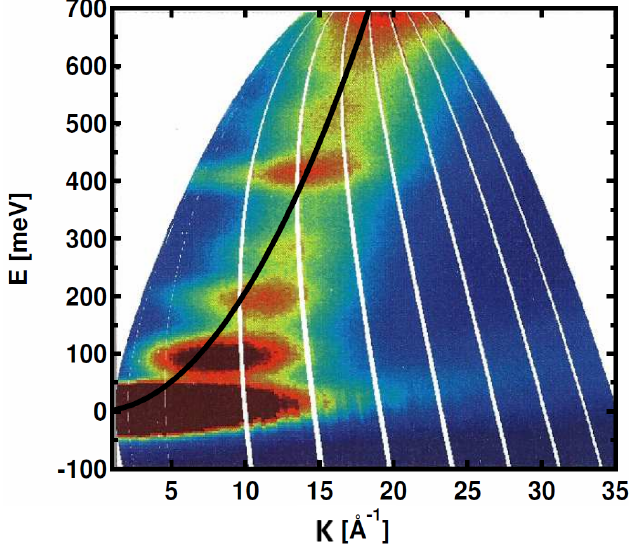
Figure 2. Experimental S ( K , E ) intensity map of ice Ih at 20 K and 1 bar, recorded on MARI [16]. E 0 = 750 meV. The shown black line (parabola) is the conventional recoil trajectory of a free H. The strong intensity ribbon at E ≈ 0 is mainly due to the aluminum cell containing the water (ice). The intensity peak centered at E ≈ 420 meV and K ≈ 14 Å − 1 represents the vibrational stretching OH-vibrations. See the discussion in the text. (Reproduced from reference [17] with